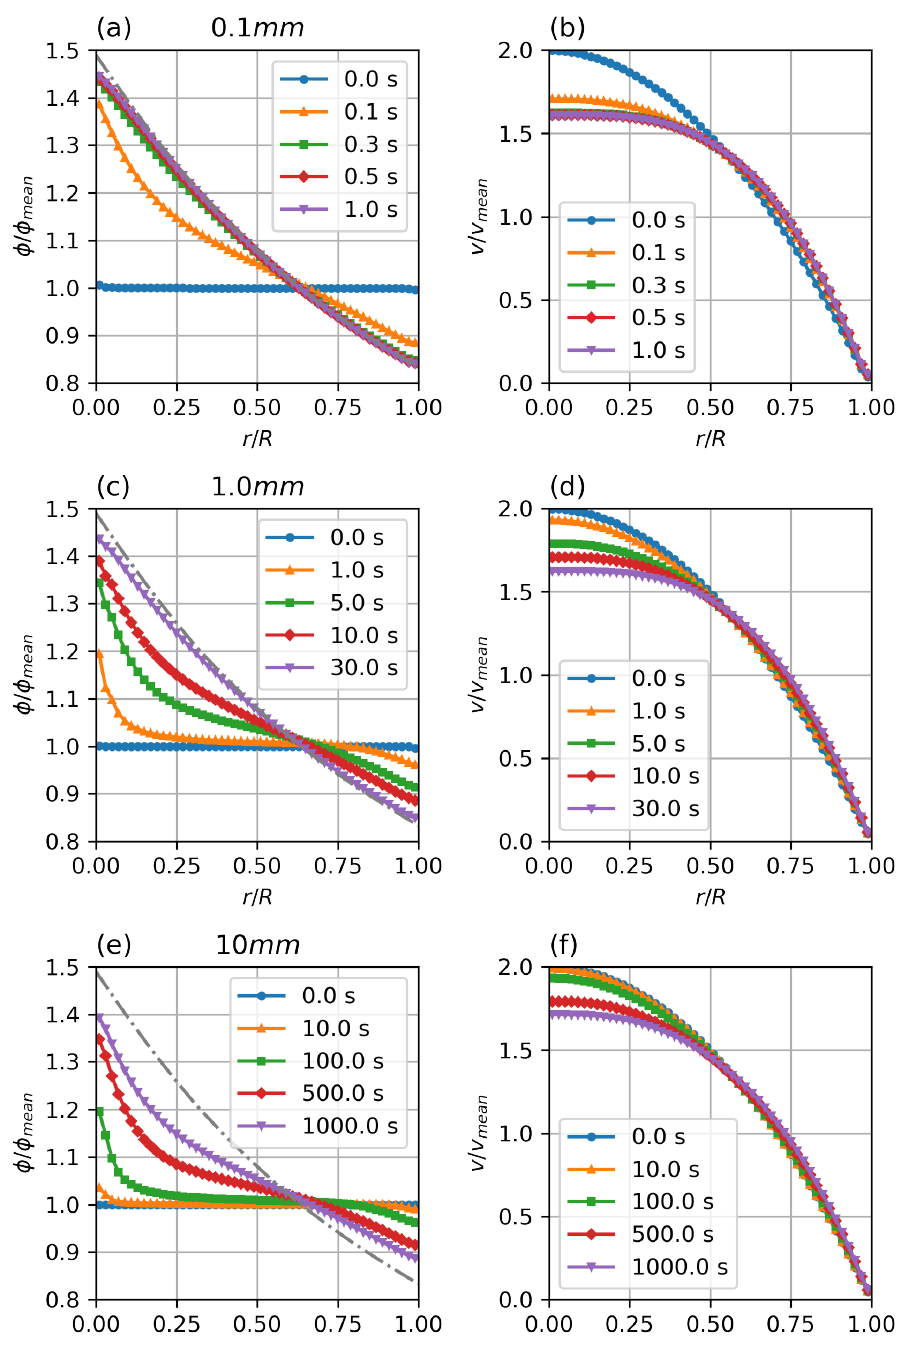
Figure 6. Transient particle distribution ( a , c , e ) and velocity profiles ( b , d , f ) for different diameters. Parameters: fully developed pipe flow, R = 0.1 ( a , b ) , 1.0 ( c , d ) , 10 ( e , f ) mm, V = 0.0065 ( a , b )